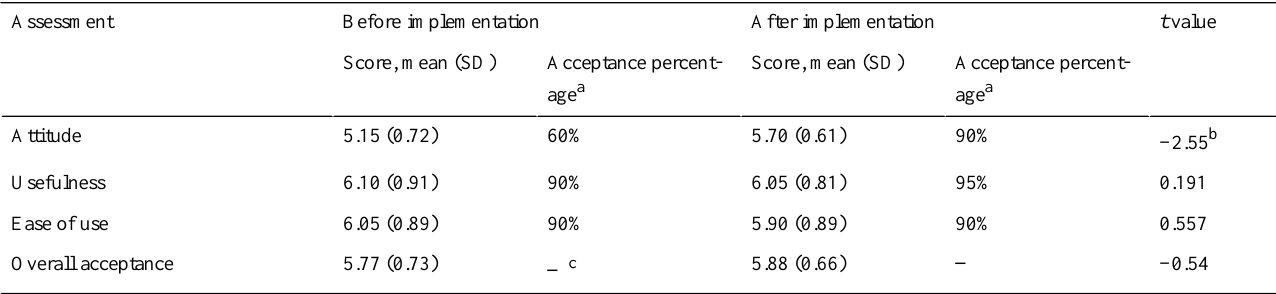
Table 1. Acceptance of competency-based medical education assessments before and after system implementation